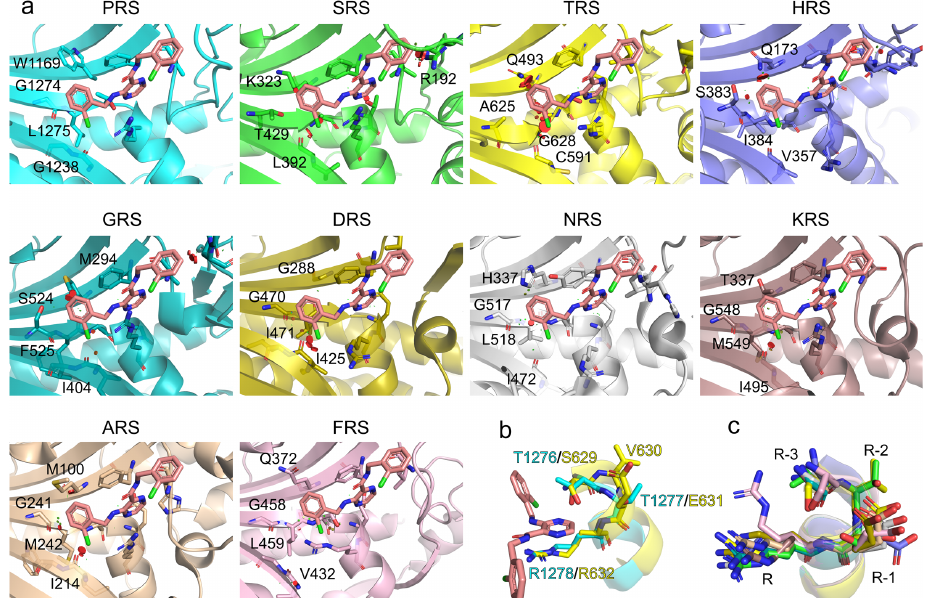
Figure 7. Structural analysis of potential selectivity of HcProRS inhibitors. ( a ) Models of compound 3b in HcProRS and the other nine human class II aaRSs. Crystal structures of human SerRS (PDB ID: 4L87), ThrRS (PDB ID: 4HWT), HisRS (PDB ID: 4G84), GlyRS (PDB ID: 2ZT5), AspRS (PDB ID: 4J15), AsnRS (PDB ID: 5XIX), LysRS (PDB ID: 6CHD), AlaRS (PDB ID: 4XEM) and PheRS (PDB ID: 3L4G) are used for superposition. All protein structures are shown as cartoon representa- tions with corresponding interacting residues shown as sticks. The red discs represent potential VDW overlaps or steric clashes between 3b and aaRS residues as calculated in Pymol. ( b ) Superposition of the N-terminus of motif-3 α -helix of HcProRS:Pro: 3b (cyan) and human ThrRS (yellow; PDB ID: 4HWT). The N-terminus of motif-3 α -helix in HcProRS is one residue shorter than that in ThrRS. ( c ) Superposition of N-terminus of motif-3 α -helix of all other nine human class II aaRSs. Counting from the invariant stacking arginine of motif-3 showed that all human class II aaRSs (with an excep- tion of HcProRS) have four residues at the N-terminus of this α -helix. This structural difference may affect the binding of the pyrazinamide